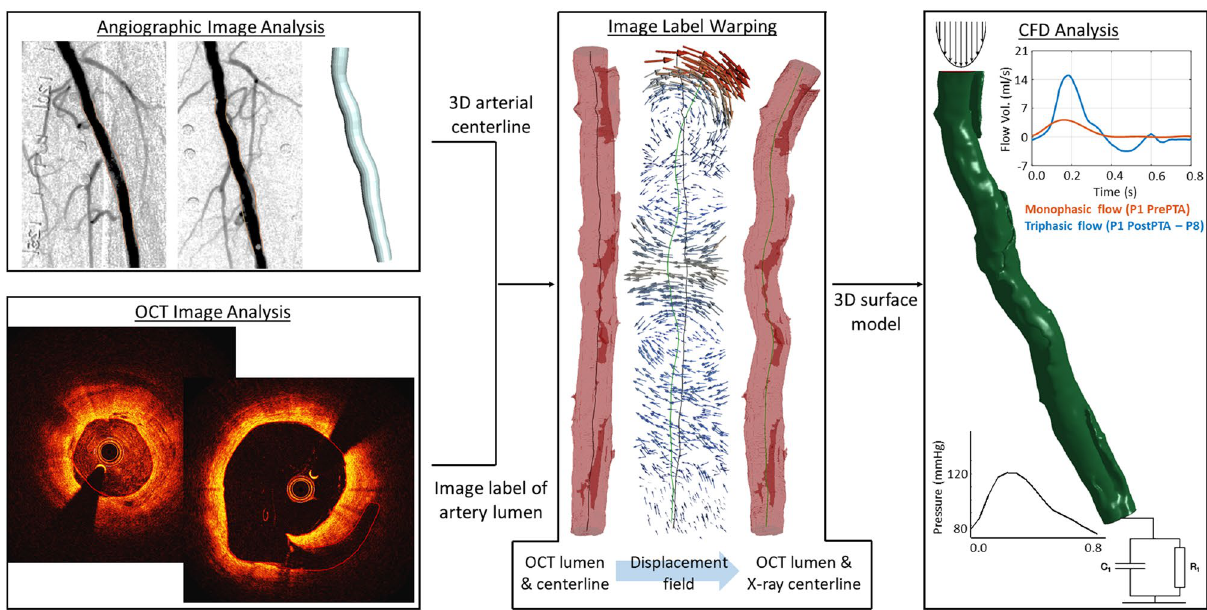
Figure 1. Outline of the reconstruction framework to generate 3D models of the artery from clinical data and obtain flow markers related with restenosis: The arterial centerline is generated from two orthogonal angiographic images, where the boundary of the artery lumen is identified using b-splines (in yellow) and triangulated into 3D-space (top-left); the lumen geometry, including arterial dissections, is segmented by b-splines (in red) from OCT images with sub-millimeter accuracy (bottom left); the image label containing the OCT-based lumen geometry in voxel format is warped onto the X-ray arterial centerline (in green) based on the displacement field computed between the OCT (in black) and X-ray centerlines (middle); and, finally, the surface model generated from the warped image label is meshed and transferred to a CFD solver, where a parabolic flow profile and a two-parameter Windkessel model are applied to the inlet and outlet, respectively. (Generated by LS-DYNA R10.1, http:// www. lstc. com/ produ cts/ ls- dyna).